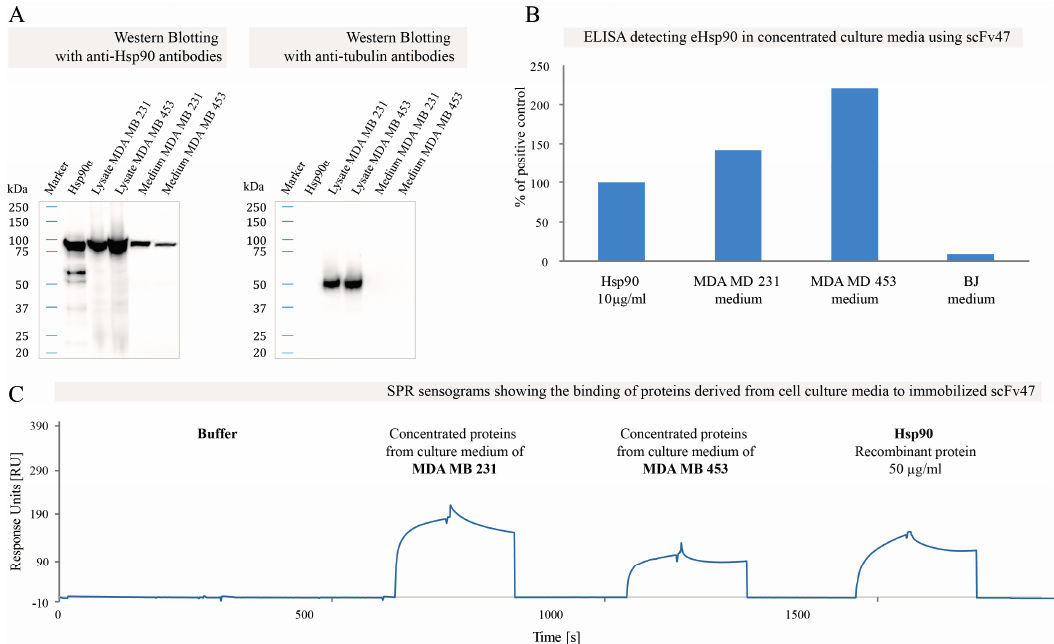
Figure 4. Interaction of scFv47 with eHsp90: ( A ) Western blot analysis of concentrated serum-free media derived from MDA MB 231 and MDA MB 453 cell cultures using